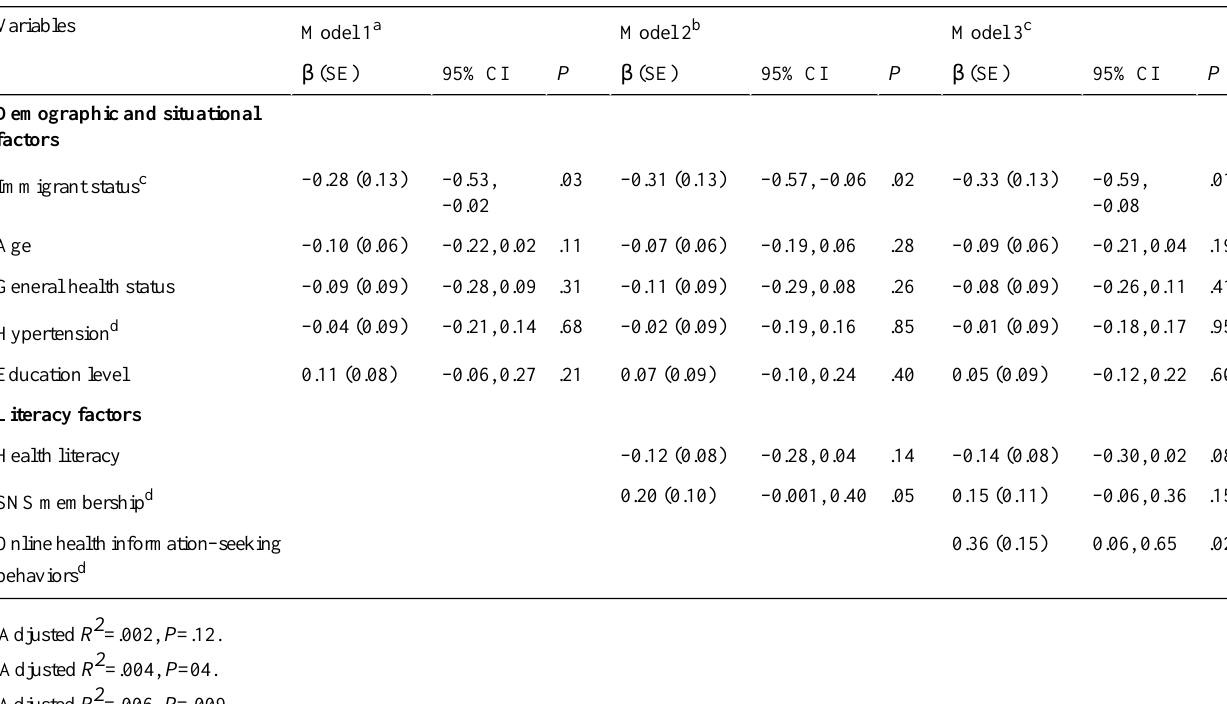
Table 4. Linear regression: association between online health information–seeking behaviors and vegetable consumption.